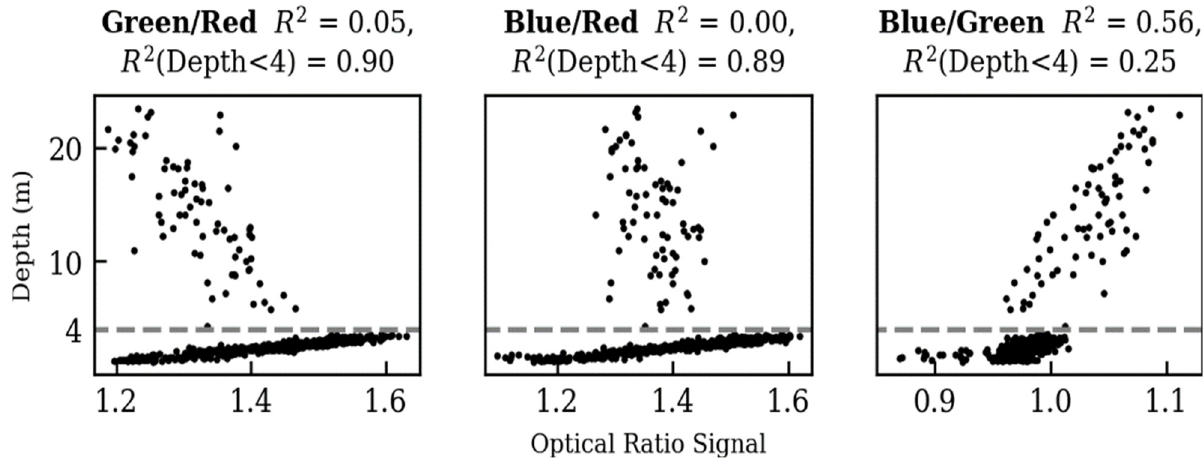
Figure 3. Examples of depth versus computed single-band optical ratios. Coefficients of determination R 2 are displayed for the entire ground-truth dataset and for depth < 4 m.